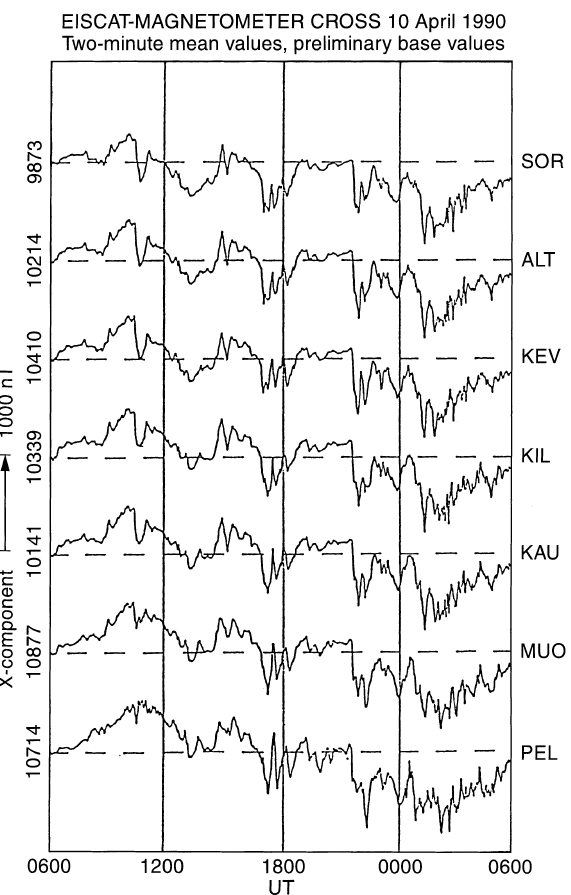
Fig. 5. EISCAT magnetometer data (geographic X -component) on 9– 11